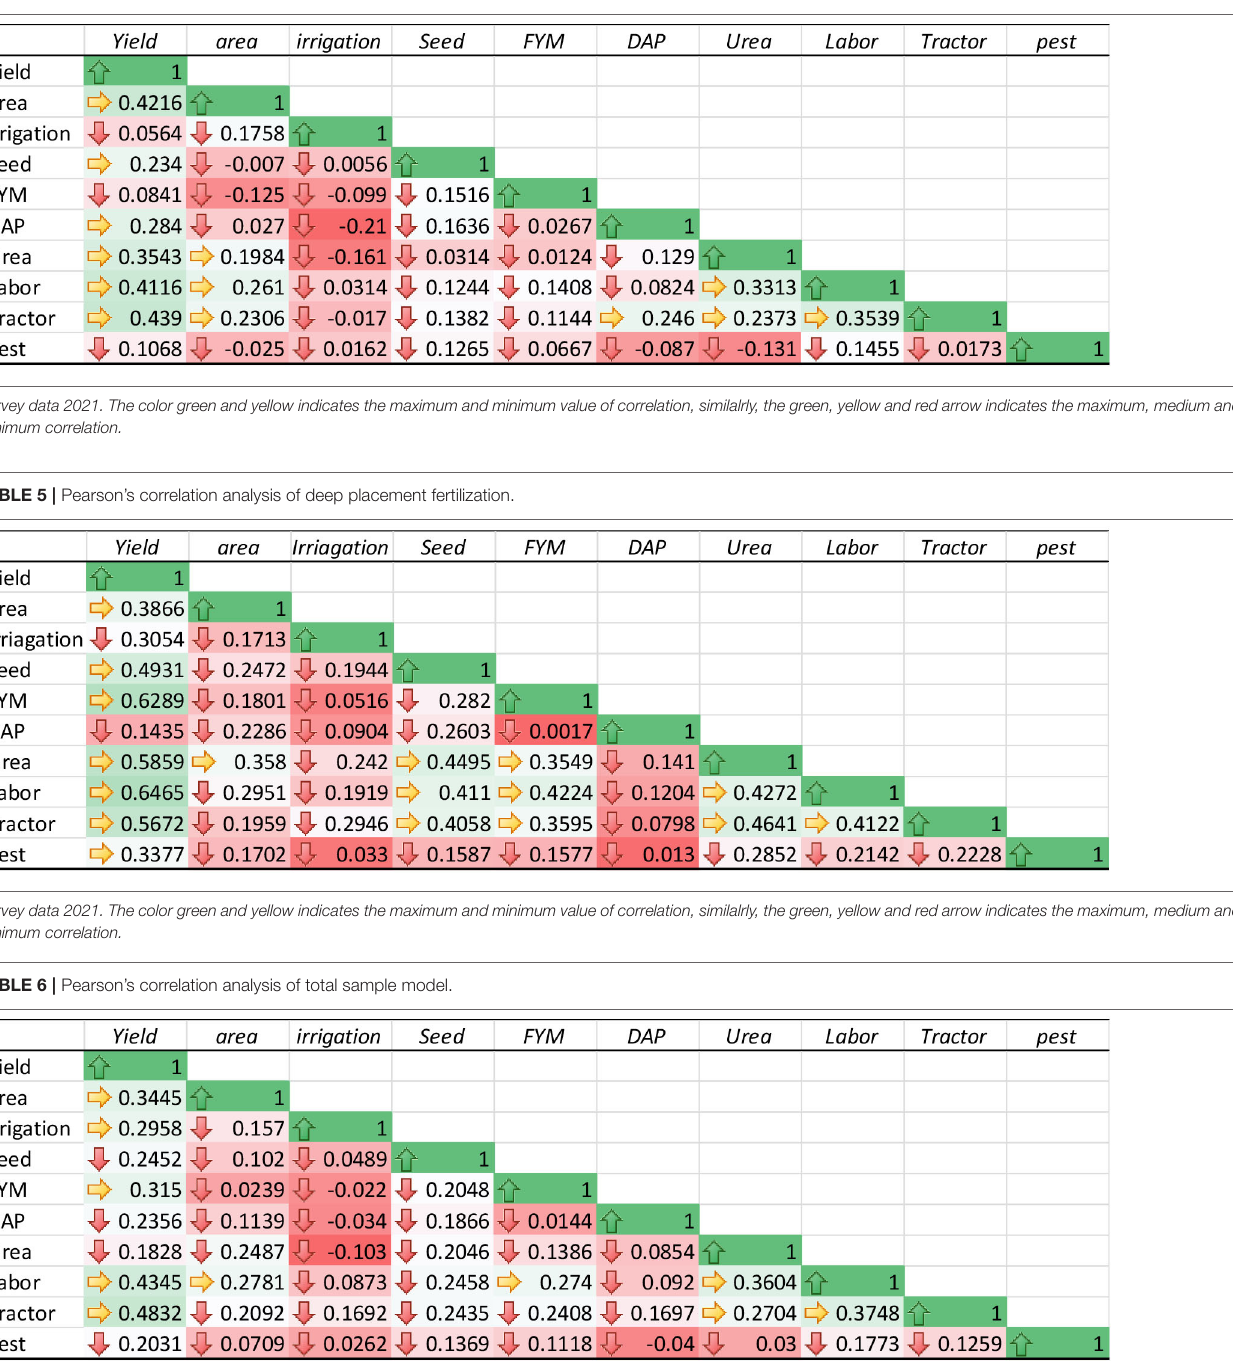
TABLE 4 | Pearson’s correlation analysis of top-dressing fertilization.